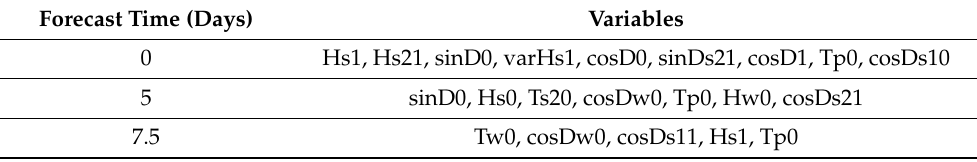
Table 3. Selected features for the final RF models. The full names of variables can be found in Table 1. Forecast Time